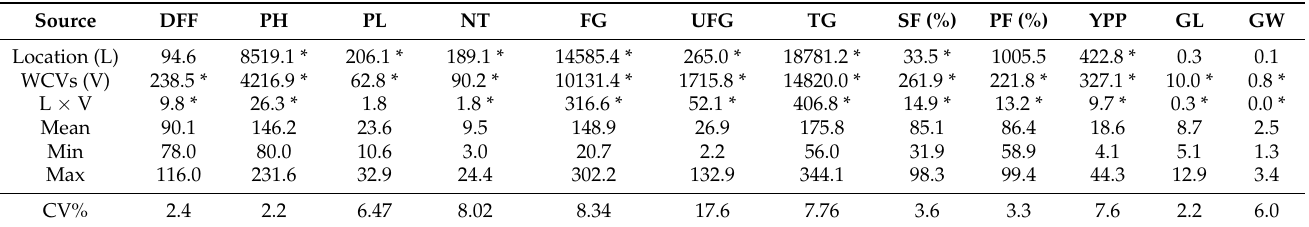
Table 2. Pooled ANOVA for twelve different agro-morphological traits.